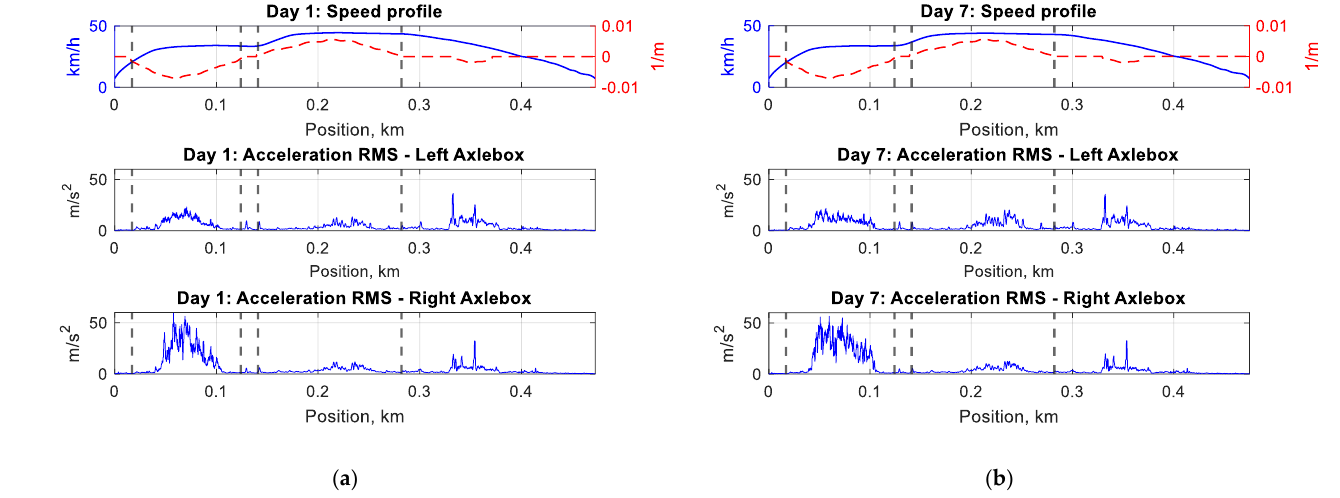
14 of 19 Table 3. Parameters used in the algorithm for the estimation of the power spectrum of rail irregu- larity.